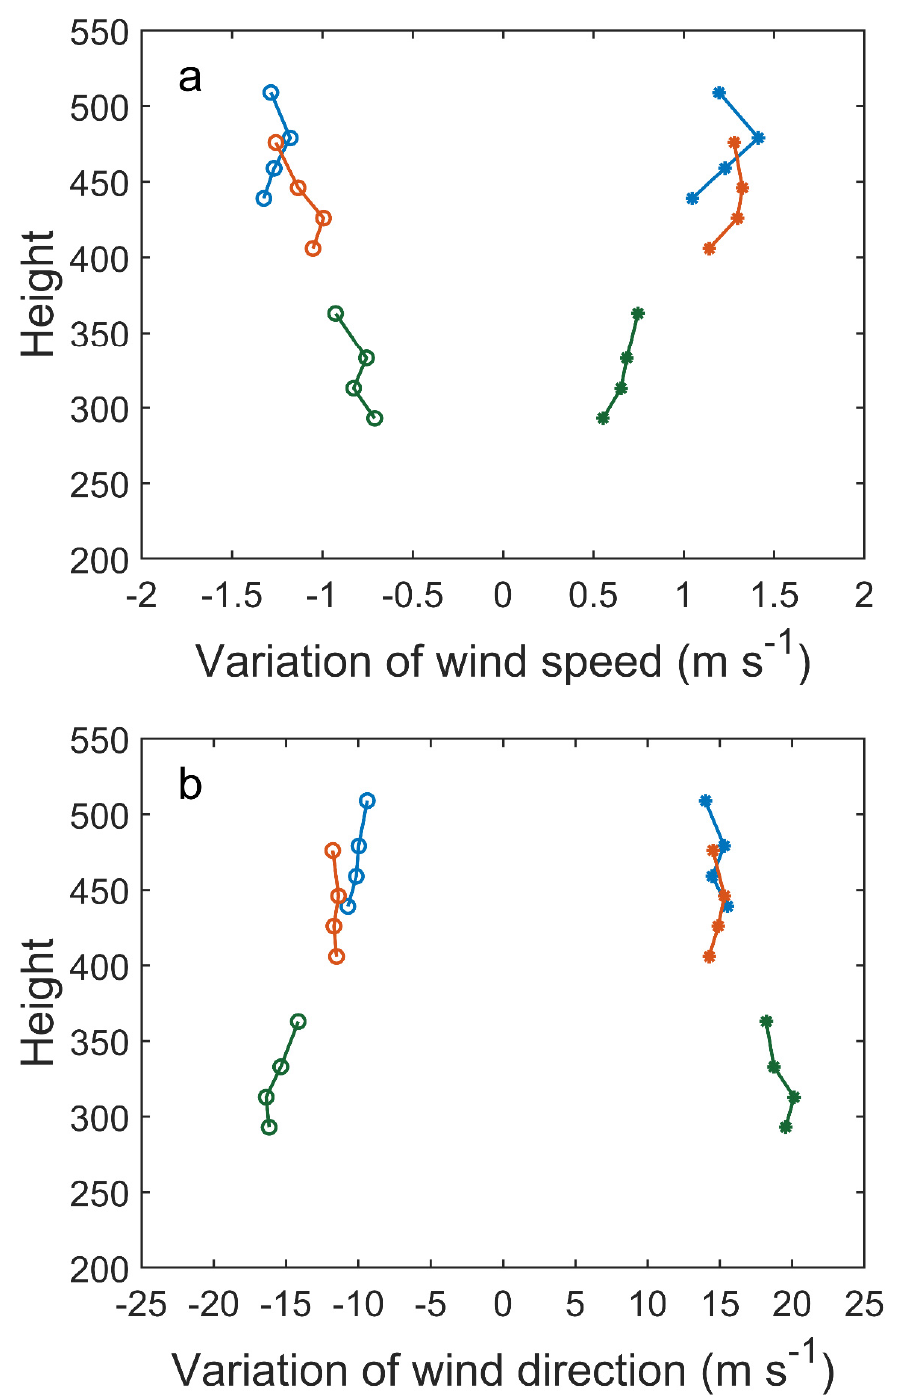
Figure 7. The range of diurnal variation in the mean wind speed ( a ) and wind direction ( b ). Circles: the difference between the minimum and the mean values; Stars: the difference between the maximum and the mean values. Blue: Tower 1; Orange: Tower 2; Green: Tower 3.